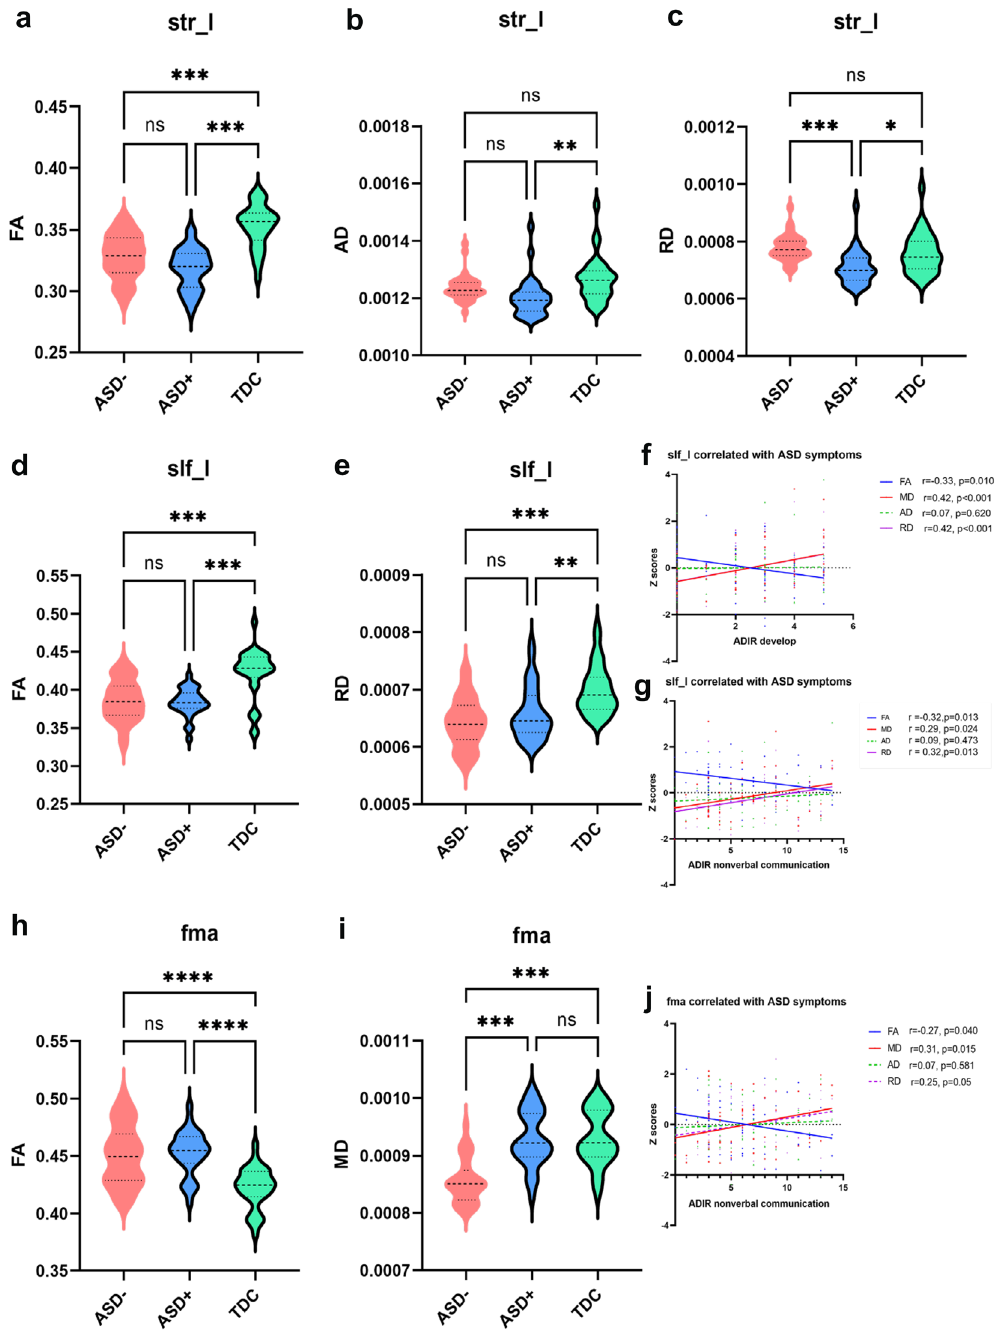
Figure 5. Varied fiber tract of ASD via probabilistic tractography. *p < 0.05; **p < 0.01; ***p < 0.001. ASD− ASD with optimal outcome, ASD+ ASD with persistent symptoms, TDC typically developing controls, str_l